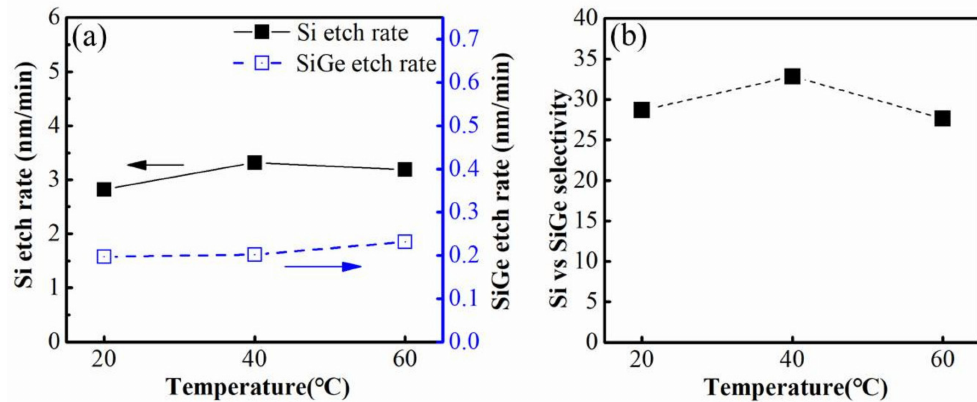
Figure 3. ( a ) The lateral etching rate of Si and the vertical etching rate of Si 0.7 Ge 0.3 , ( b ) the etching selectivity of Si to Si 0.7 Ge 0.3 under ACT@SG-201 at different temperature. At the same time, the etching rate of Si, Si 0.7 Ge 0.3 and selectivity of Si to Si 0.7 Ge 0.3 with different concentration of ACT@SG-201 solution at 40 ◦ C are presented in Figure 4a,b. As we can see that the etching rate of Si and Si 0.7 Ge 0.3 are decreasing with the increasing of the concentration of ACT@SG-201. However, the selectivity of Si to Si 0.7 Ge 0.3 increase from 20.67 to 32.84 because the etching rate of Si 0.7 Ge 0.3 decreases more than that of Si. Based on the above results, the ACT@SG-201 without any dilution at the temperature of 40 ◦ C is chosen as the optimal etching solution for the selective etching of Si to Si 0.7 Ge 0.3 .